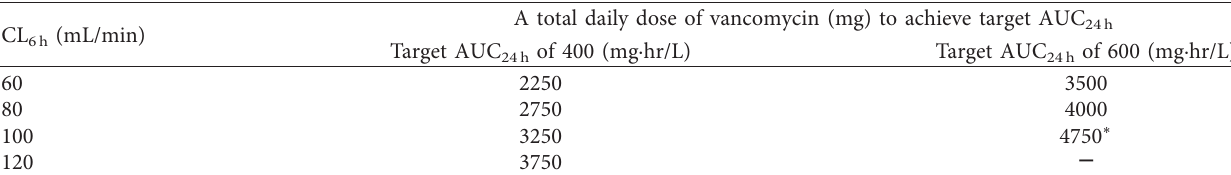
∗ Target AUC 24h of 400mg.hr/L may be considered because of the total daily dose > 4g. Abbreviations: CL 6h : measured creatinine clearance in 6-hour urine collection; AUC 24h : 24-hour area under the